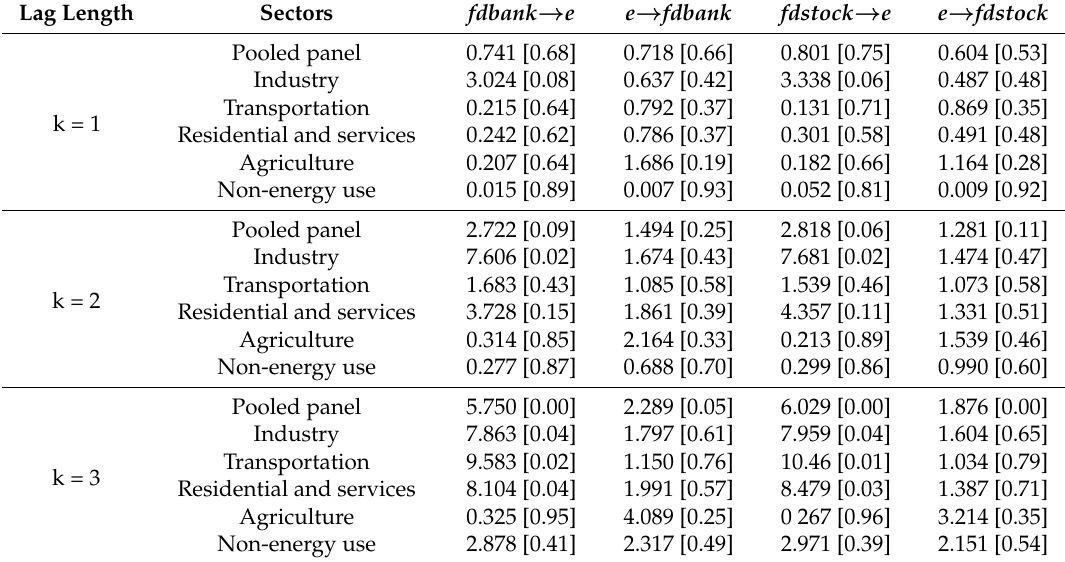
Table 8. Causality